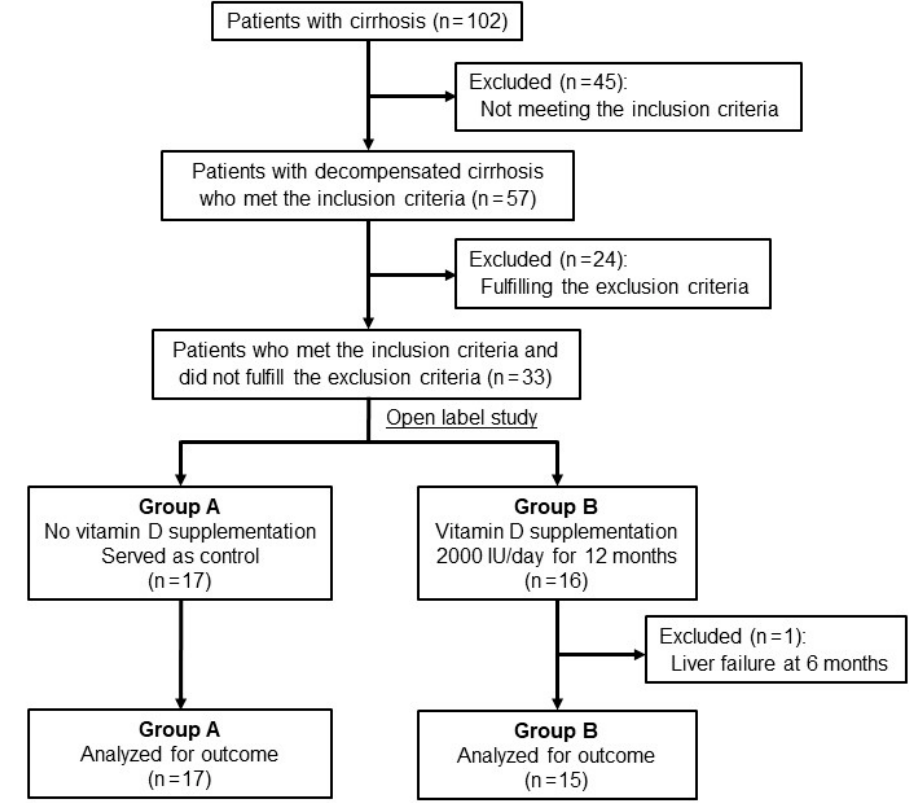
Figure 1. Flow diagram of patients included in the present study.